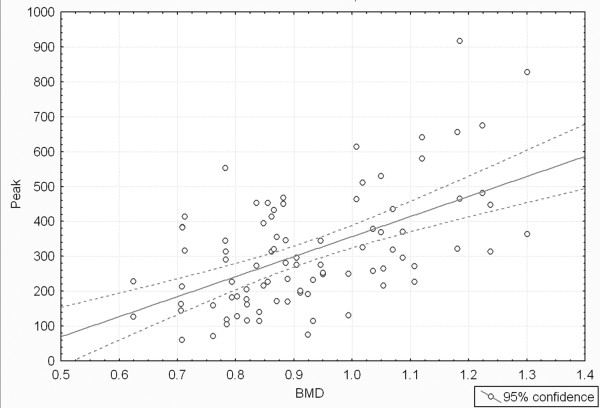
Load-to-failure versus BMD showing regression line and 95% confidence lines (r = 0.55, correlation is significant, P < 0.0001).